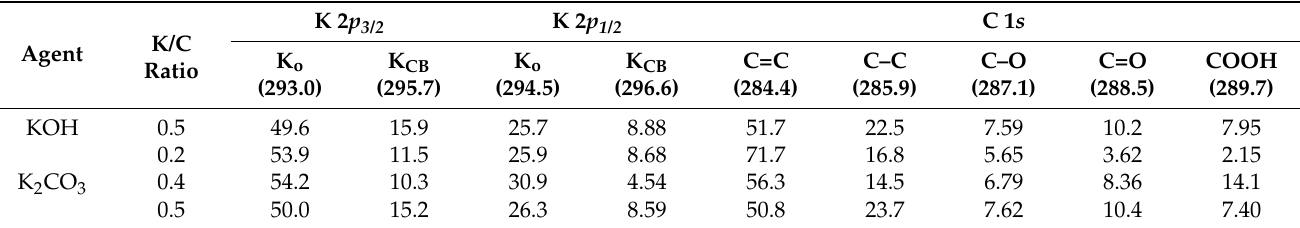
Table 2. Deconvolution of K 2 p and C 1 s XPS spectra of the KOH/K 2 CO 3 -impregnated carbon precursors.